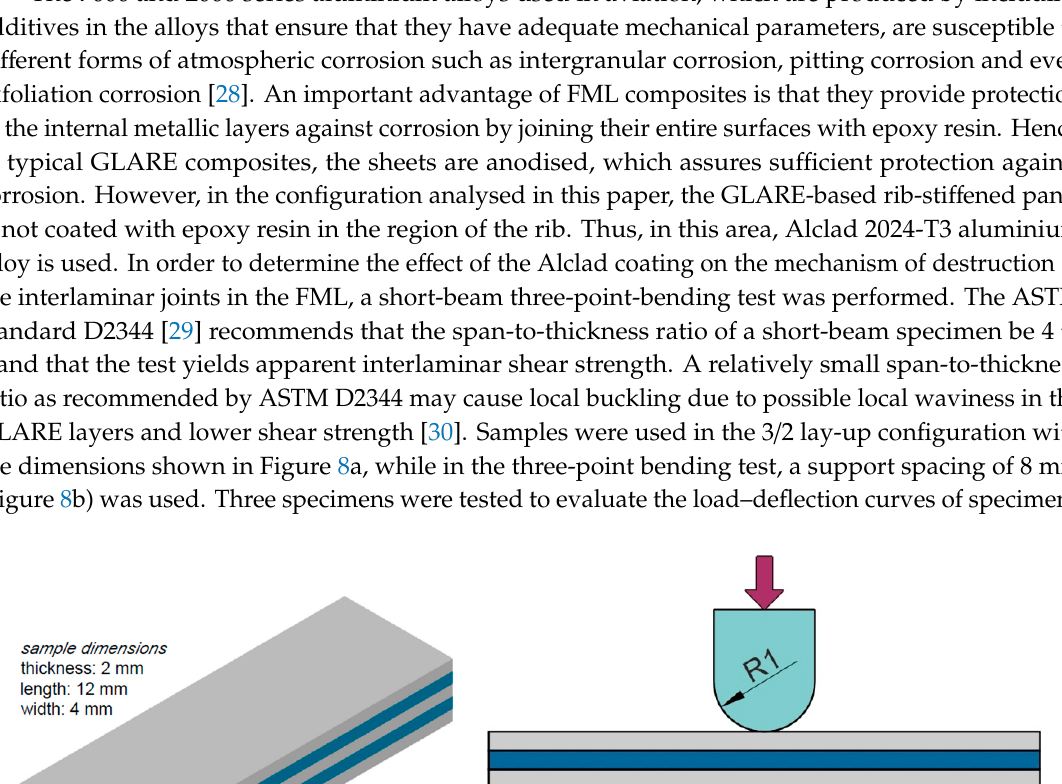
Figure 7. Sample for testing the interlaminar strength of the FML composite in the drum peel test.